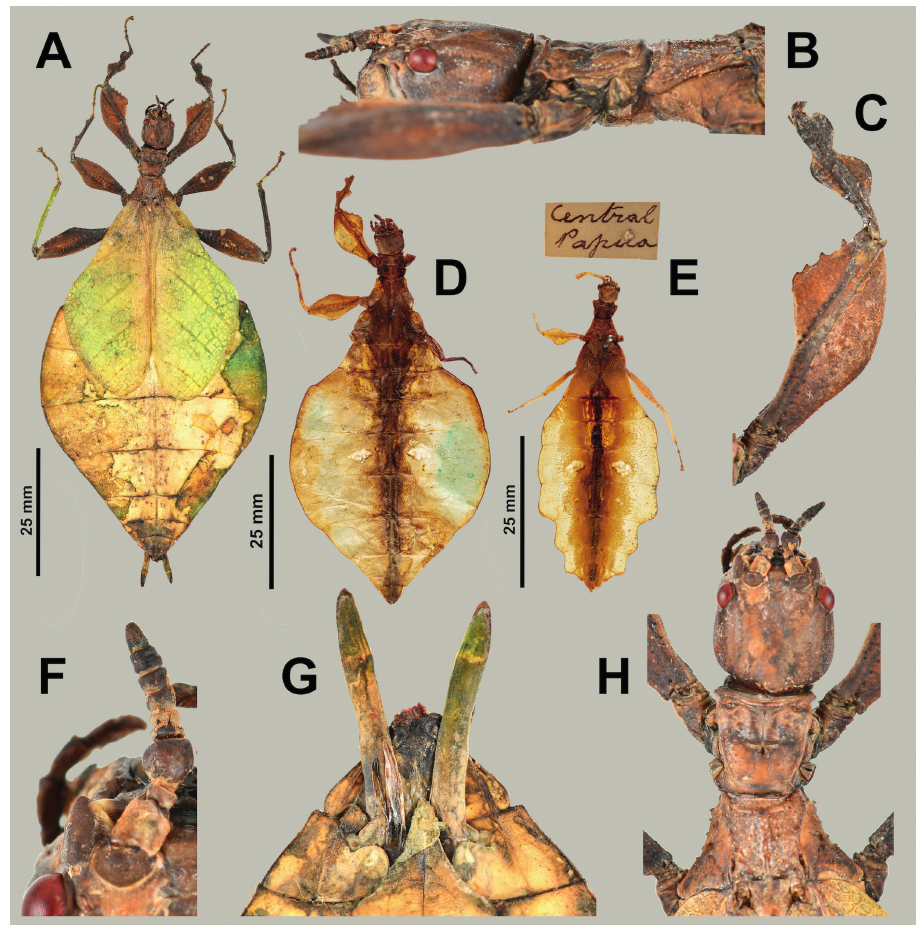
Figure 7. Rakaphyllium schultzei comb. nov. non-type material specimens A–C, F–H adult female from Coll SLT, Indonesia: Jayapura, Klaisu D, E nymphs from MAMU A habitus, dorsal B details of head through thorax, lateral C profemora, dorsal D female nymph without collection data (MAMU) E male nymph with slightly undulating abdomen with associated data label above (MAMU) F details of antenna, dorsal G genitalia, ventral H details of head through thorax, dorsal. Scale bars only associated with images A, D, E . Photographs A–C, F–H taken by Rene Limoges (IMQC) D, E courtesy of Chau Chak Wing Museum, the University of Sydney, and photographs taken by David